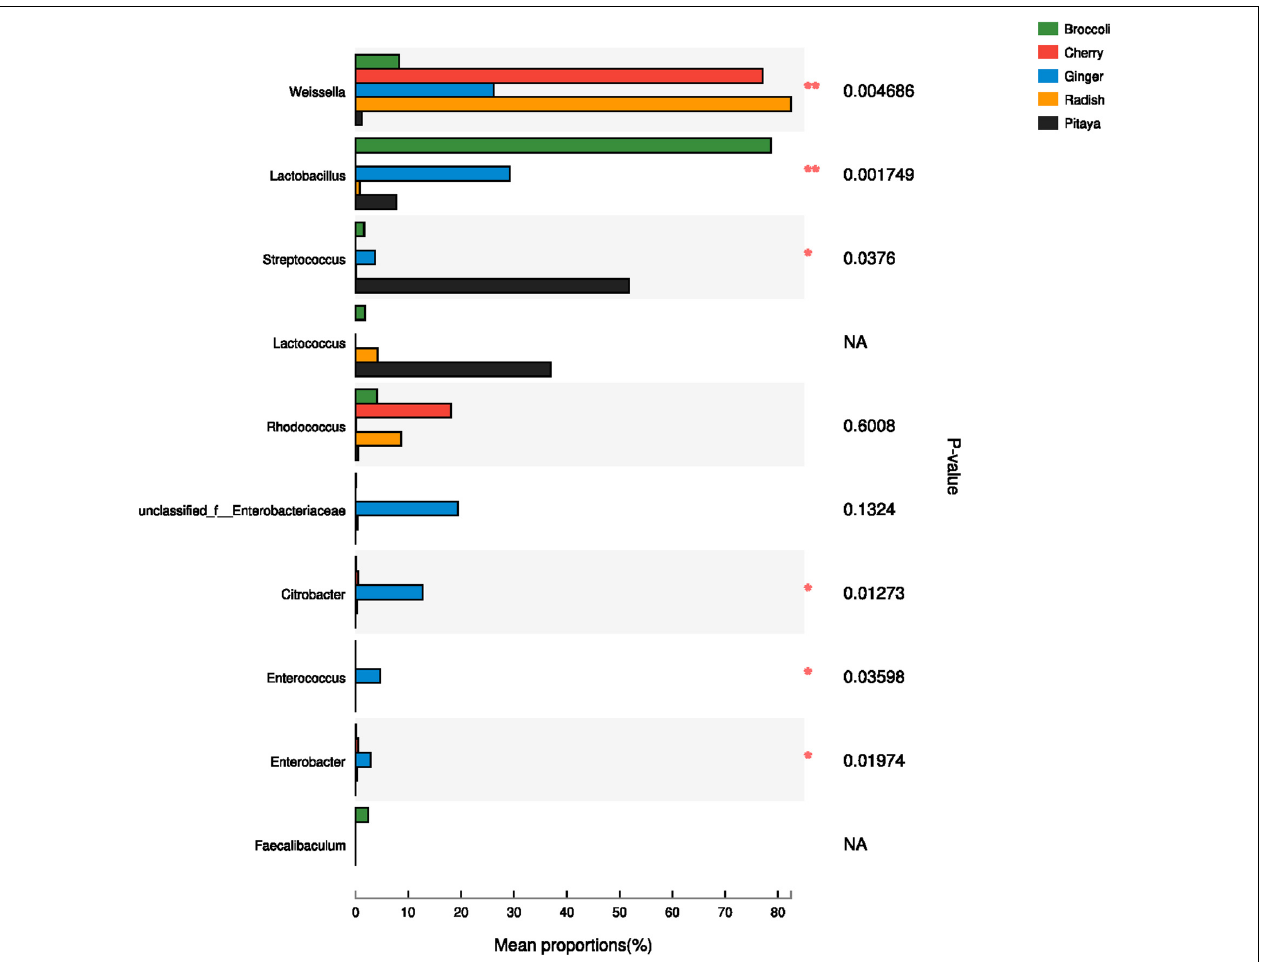
FIGURE 3 | Comparison of dominant genera in five samples using one-way ANOVA. In the vertical axis, the different identified bacteria genera are depicted; the length of the corresponding column indicates the average of the relative abundance of the genus in the different samples, ∗∗ P < 0.01, ∗ P < 0.05; NA, not